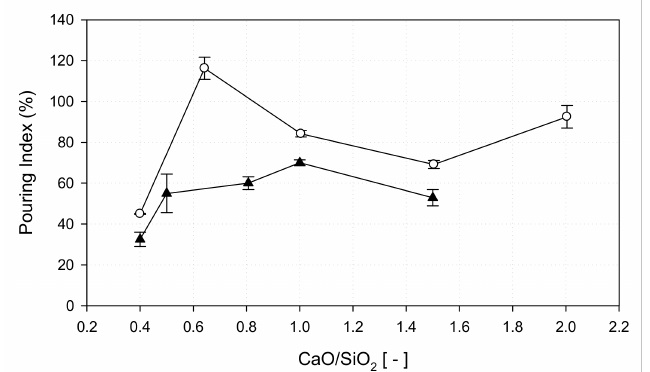
Figure 11. Results of pouring indices according to basicity (